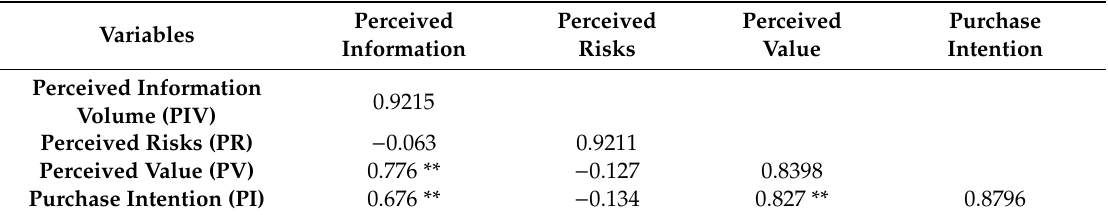
Table 6. The square root of AVE of all variables and coe ffi cient matrix. The values along the diagonal are the square root of